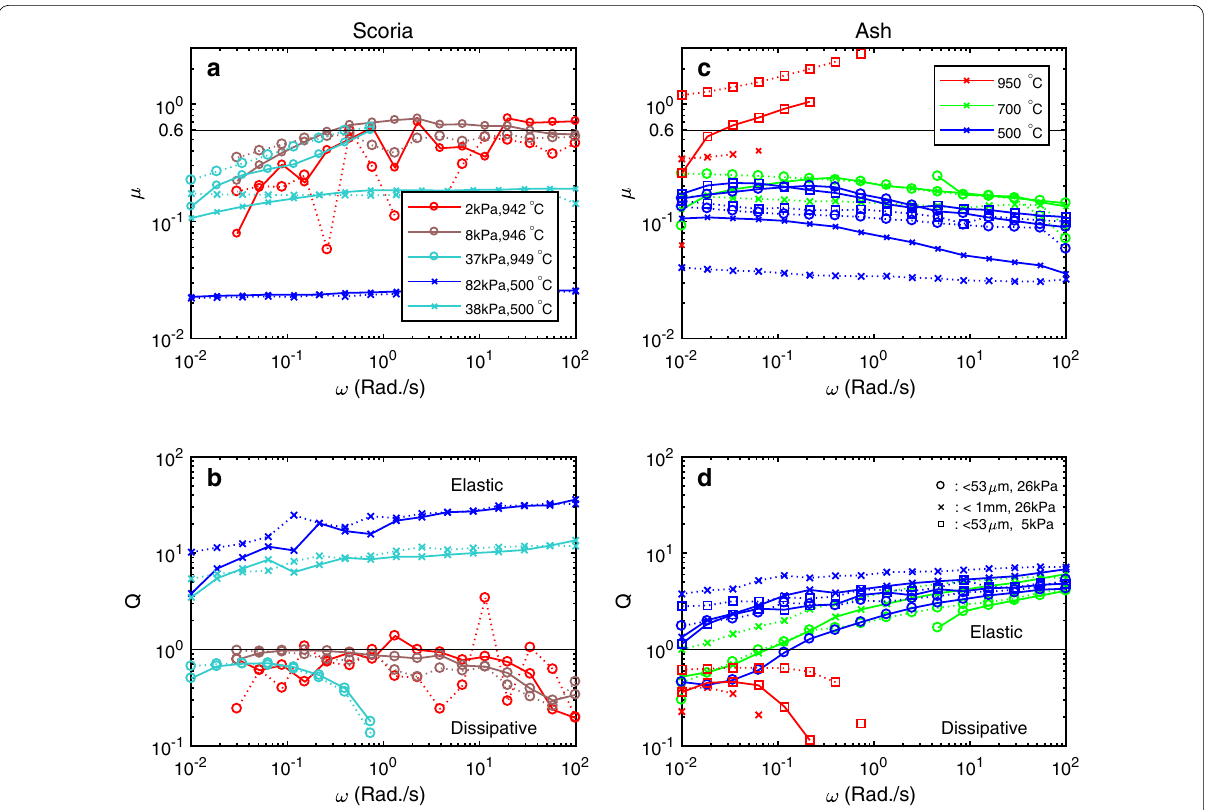
Fig. 9 Oscillatory measurements of scoriae ( a , b ) and ash ( c , d ). a The friction coefficient calculated by the ratio of the shear to normal stresses, µ = σ τ /σ N , obtained by oscillatory measurements as a function of the angular frequency ω . The color of the curves indicates the imposed normal stress as shown in the legend. Crosses and circles indicate the fractured and unfractured samples, respectively. Solid and dotted curves indicate the increasing and decreasing angular frequency ω , respectively. b Q (inverse of the attenuation) calculated by the phase difference between the imposed strain and the measured stress. When the energy dissipation exceeds the elastic energy, Q < 1 , and vice versa. Symbols and colors are the same as those in ( a ). c , d Same as ( a , b ) but for ash. The color of curves indicates the temperature, and symbols indicate the combinations of the size of the ash particles and the normal stresses. In these measurements, we use a strain amplitude of γ 0 = 10 −